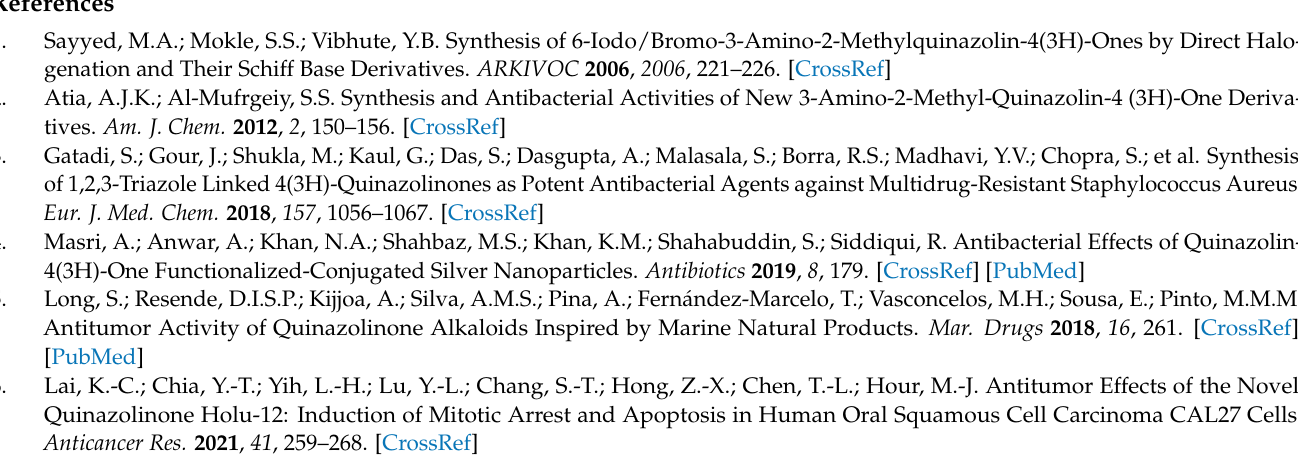
Figure S1: 1 H NMR spectra of N 2 , N 6 -bis(6-iodo-2-methyl-4-oxoquinazolin-3(4 H